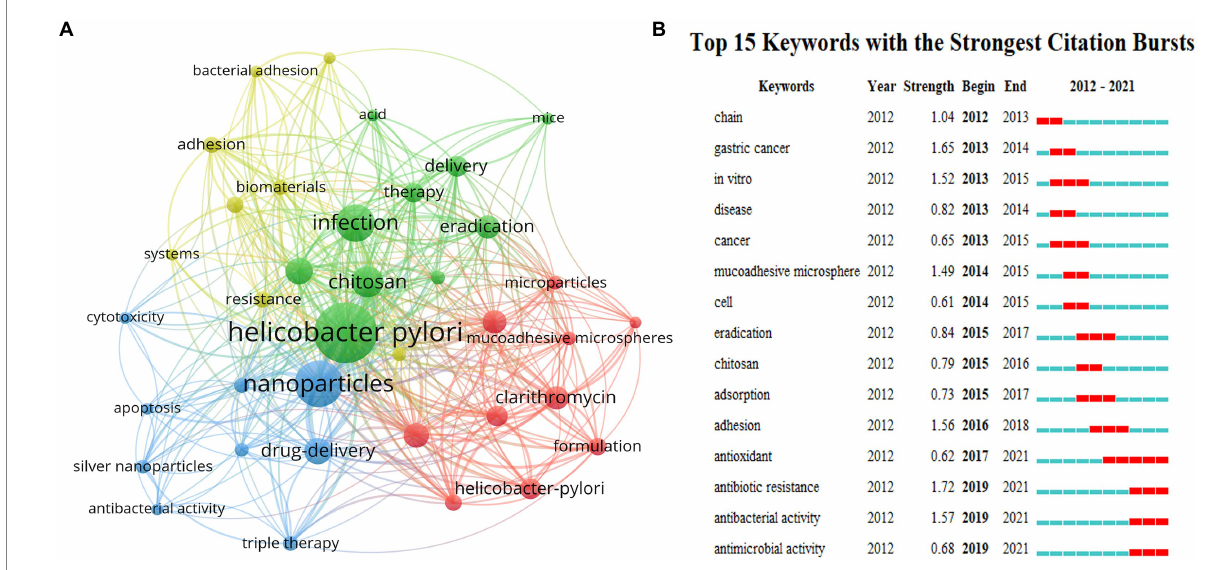
FIGURE 5 Co-occurrence network of keywords with a minimum of 5 occurrences (A) . The top 15 keywords with the strongest citation bursts (B) . All the keywords are divided into four clusters, each represented by a different color. Every node symbolizes a keyword, and the line between two keywords indicates that they have a co-occurrence relationship. Additionally, the closer the distance, the stronger the relationship (A) . Top 15 bursting keywords in articles related to eradication of H. pylori by biomaterials. The blue line represents the time line, and the interval at which bursts were found is indicated by the red portion of the blue timeline, representing the start year, end year, and outbreak duration (B)